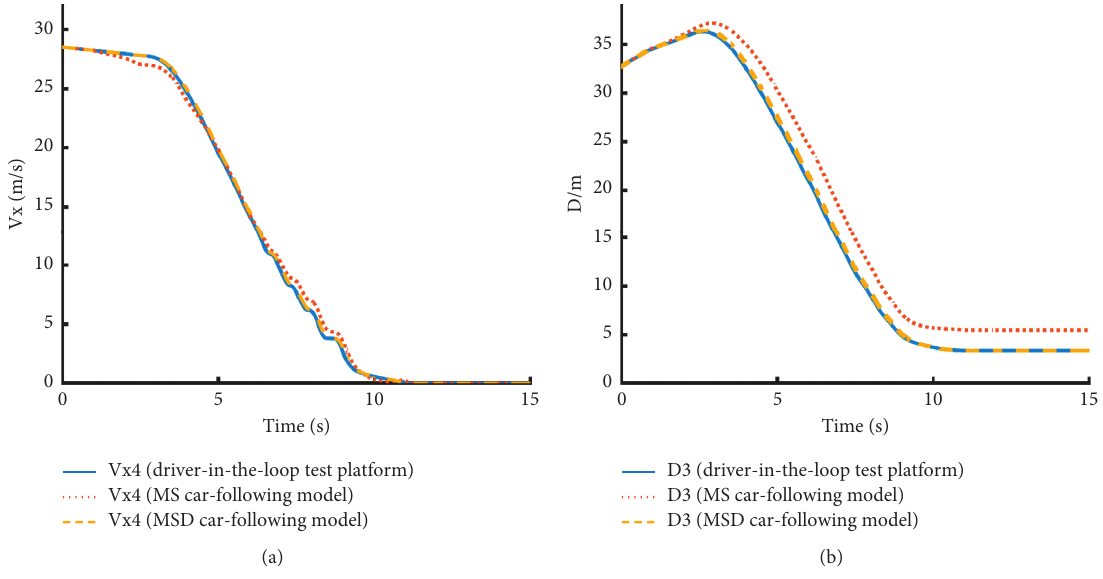
Figure 11: Results of comparison test. (a) Longitudinal velocity. (b) Intervehicle vehicles in the platoon. Figure 12(b) and Figure 12(c) show the energy generated by the spacing errors and speed errors between adjacent vehicles, respectively. It can be seen from these figures that 67.2% of the energy in the mixed platoon is caused by the HDV (the fourth vehicle), and the energy of spacing error and the energy of speed error have not achieved peak simultaneously. The peak